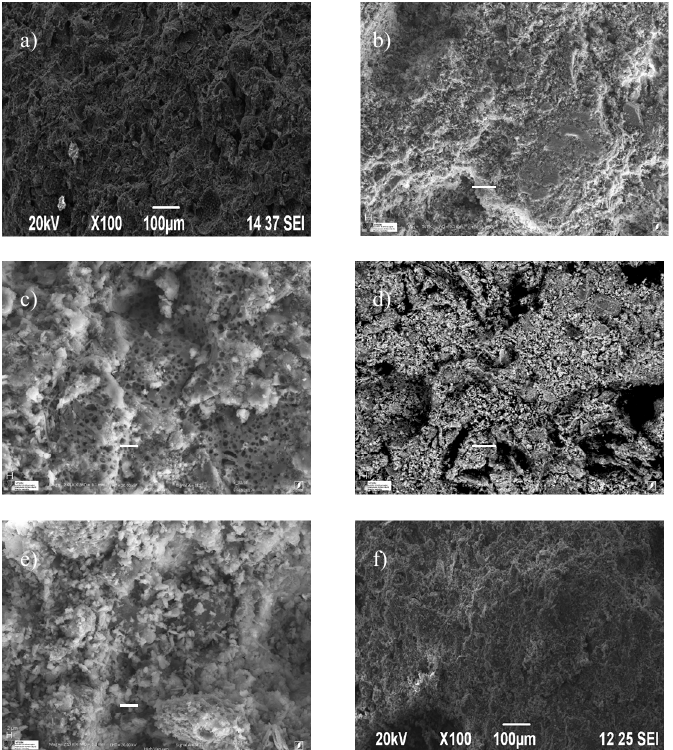
Figure 8. SEM micrographs: ( a ) Clay; ( b ) Bagasse 2%; ( c ) Bagasse 4%; ( d ) Bagasse 15%; ( e ) Sludge 15%; and ( f ) Diatomaceous Earth 15%.